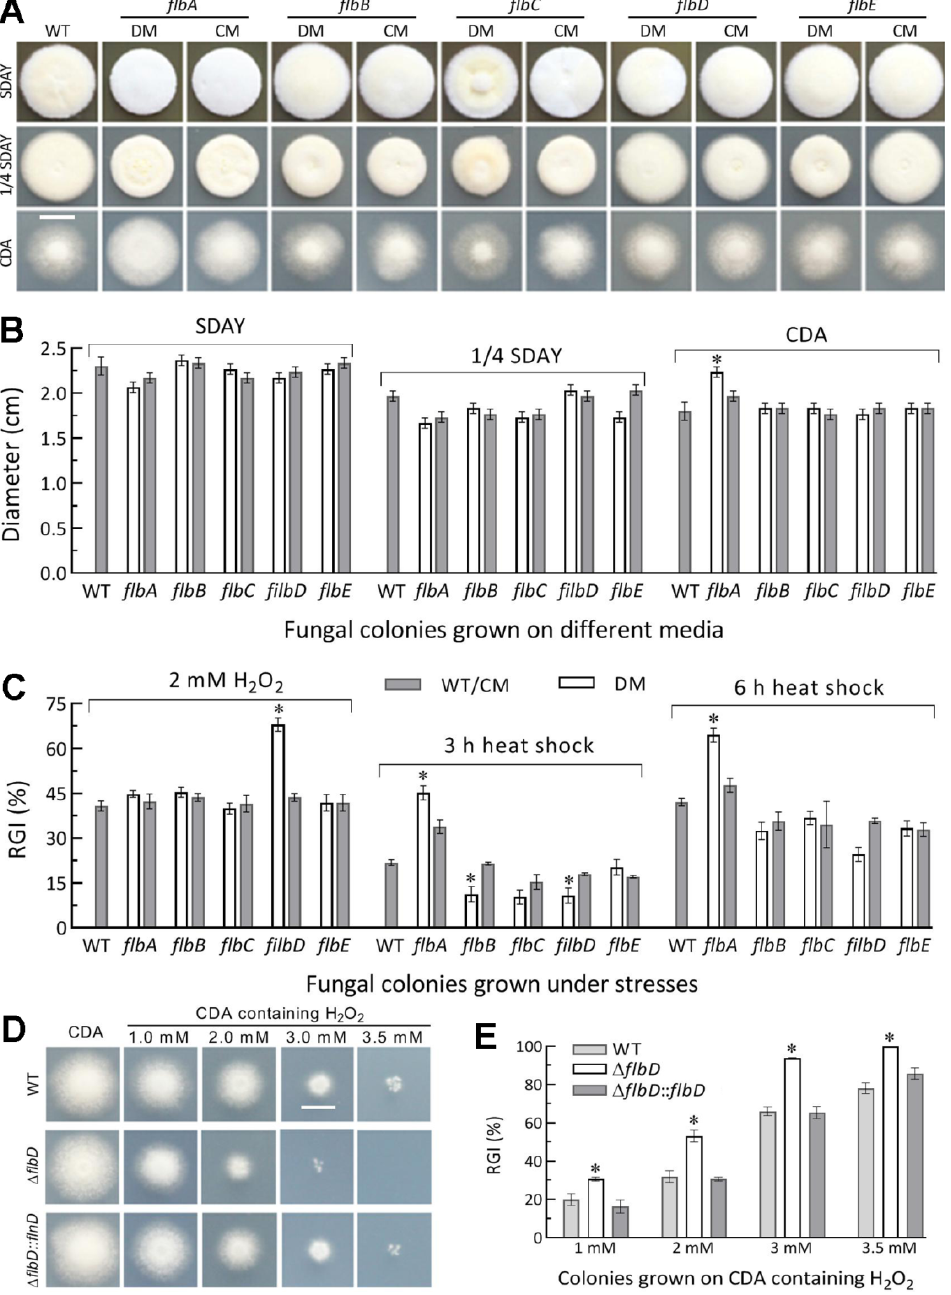
Figure 2. Radial growth rates of Δ flb mutants (DM) and control (WT and CM) strains in B. bassiana . ( A , B ) Images (scale: 10 mm) and diameters of fungal colonies grown at the optimal regime of 25 ° C and L:D 12:12 for 7 d on rich medium SDAY, 1/4 SDAY and minimal medium CDA after initiated with 10 3 conidia. ( C ) Relative growth inhibition (RGI) percentages of fungal colonies incubated at 25 ° C for 7 d on CDA containing H 2 O 2 and of SDAY colonies incubated at 25 ° C for 5-d growth recovery after exposing 2 d-old colonies to a 42 ° C heat shock for 3 or 6 h. ( D , E ) Images (scale: 10 mm) and relative growth inhibition of the Δ flbD and control strains incubated for 6.5 d on H 2 O 2 -containing CDA plates. * p < 0.05 (Tukey’s HSD). Error bars: SDs from three replicates .